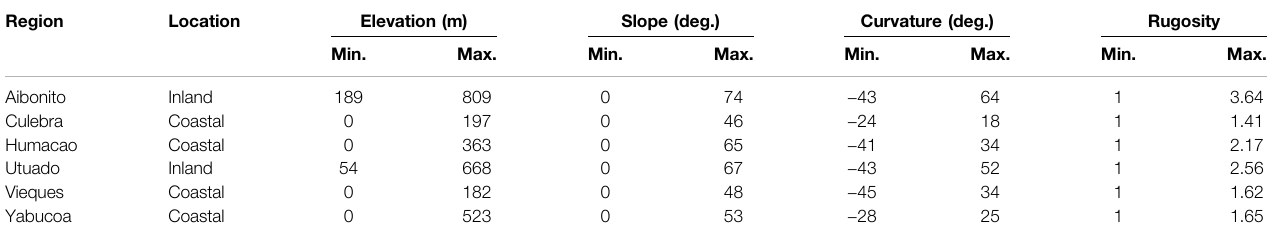
TABLE 1 | Terrain complexity parameters.